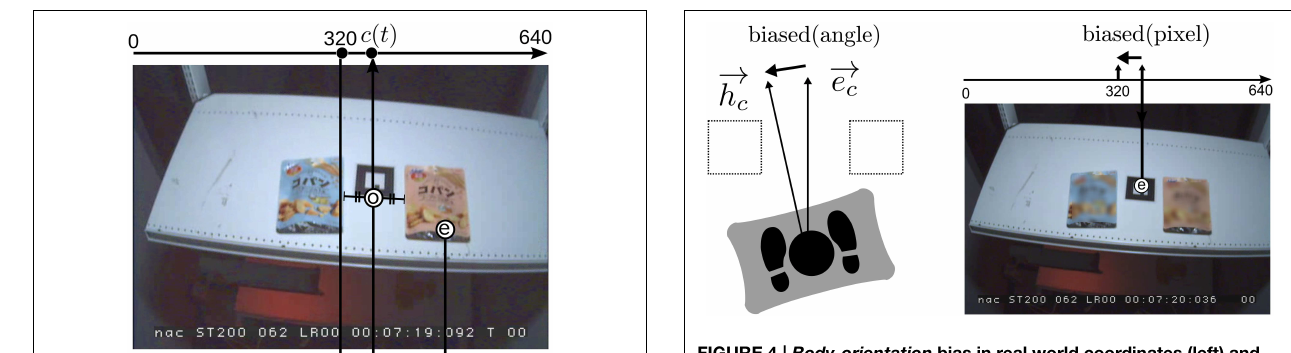
FIGURE 4 | Body-orientation bias in real world coordinates (left) and head-mounted view (right): The body-orientation bias can be observed in the coordinates of the head-mounted